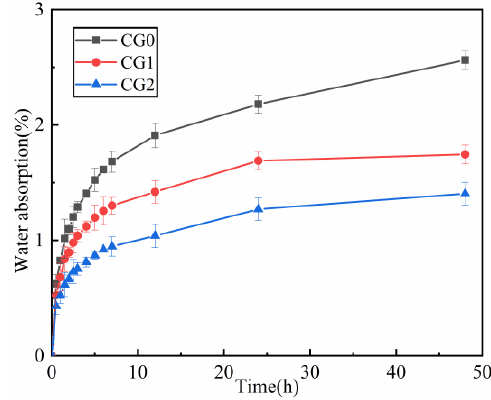
Figure 13. Water absorption of ferrochrome slag concrete.